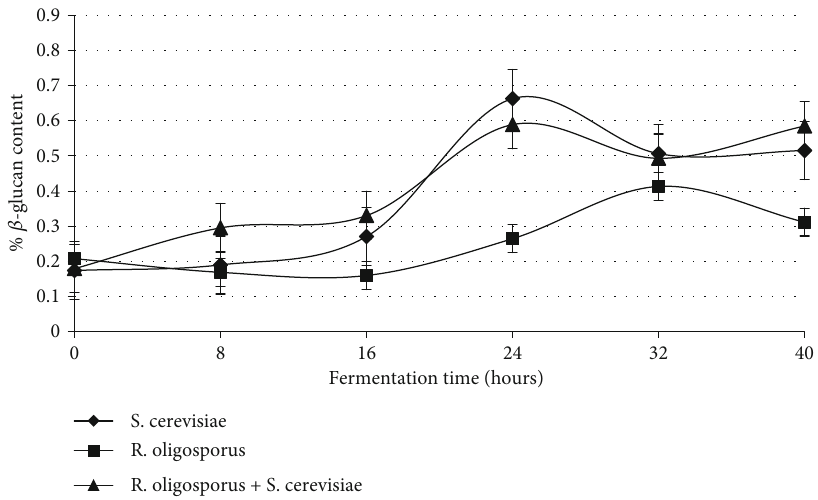
Figure 3: The β -glucan content of soybeans fermented using three kinds of starter